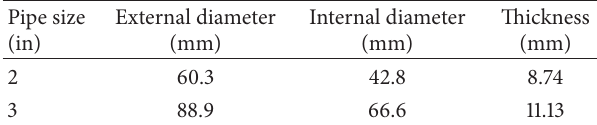
Table 2: Section